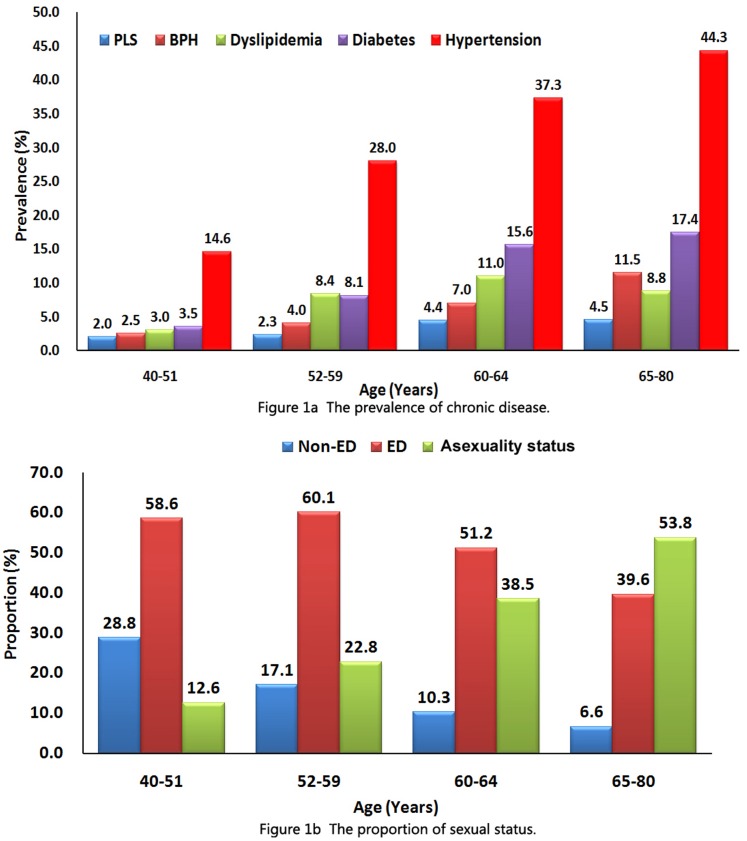
The distribution of chronic disease and sexual status among age groups.